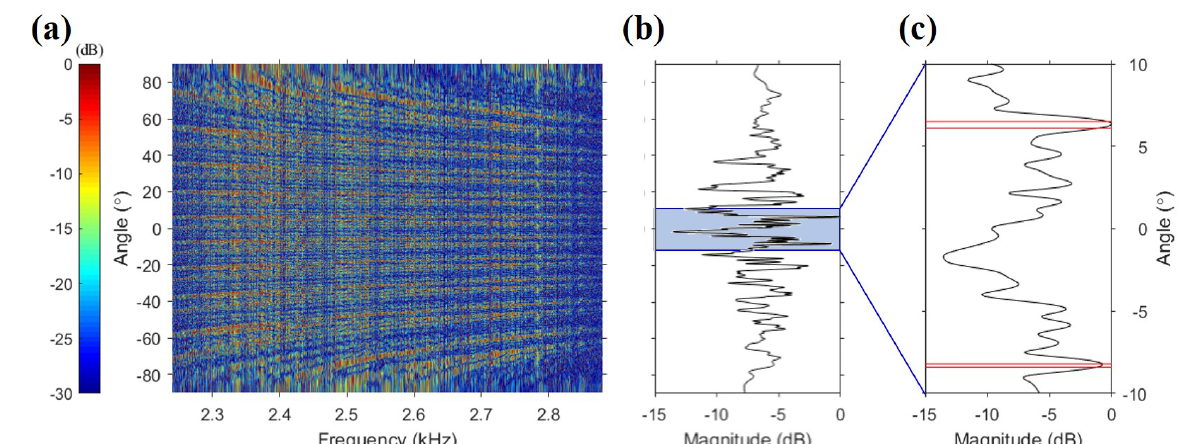
Figure 5. Conventional beamforming output using one data packet; ( a ) beamformed output as functions of the frequency (Hz) and grazing angle (deg). Aliasing occurred because of the carrier frequency, which is approximately 10 times the design frequency. ( b ) Beamformed output incoherently summed over the frequency band. ( c ) Enlargement of ( b ) from − 5 ◦ to 15 ◦ . The red lines represent the angles of all paths estimated from the channel impulse response (Figure 6). The angles cannot be estimated from beamforming because of aliasing and beam resolution.